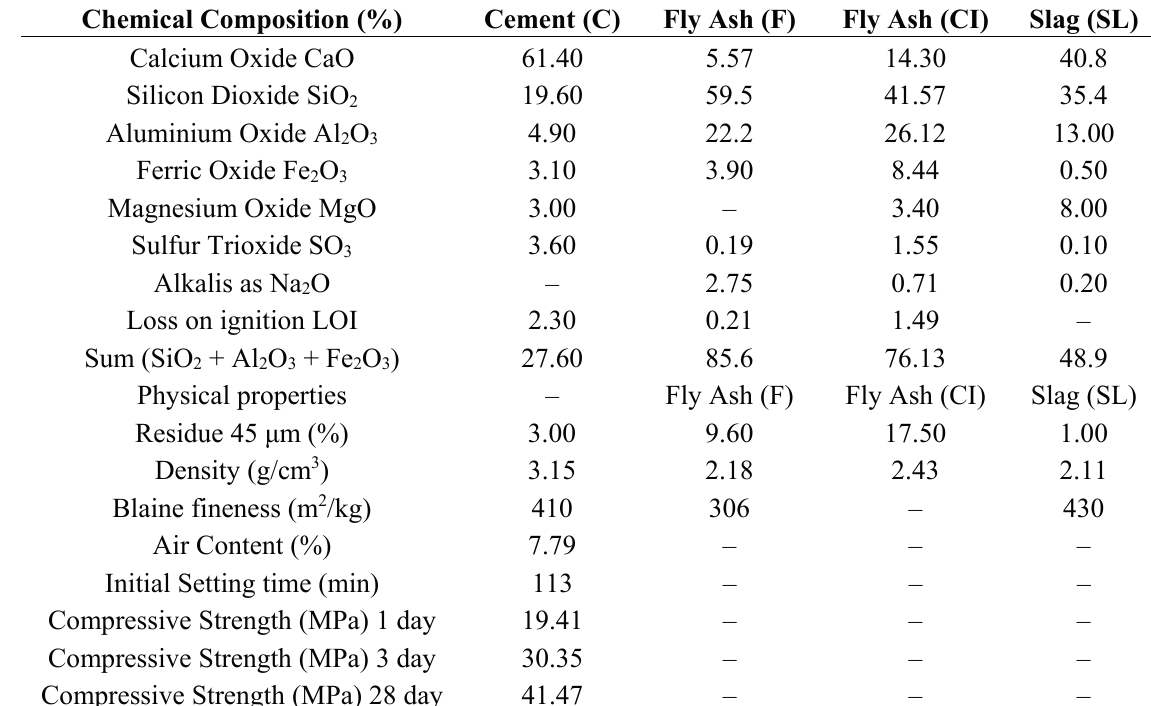
Table 1. Chemical properties of Portland cement, fly ashes and